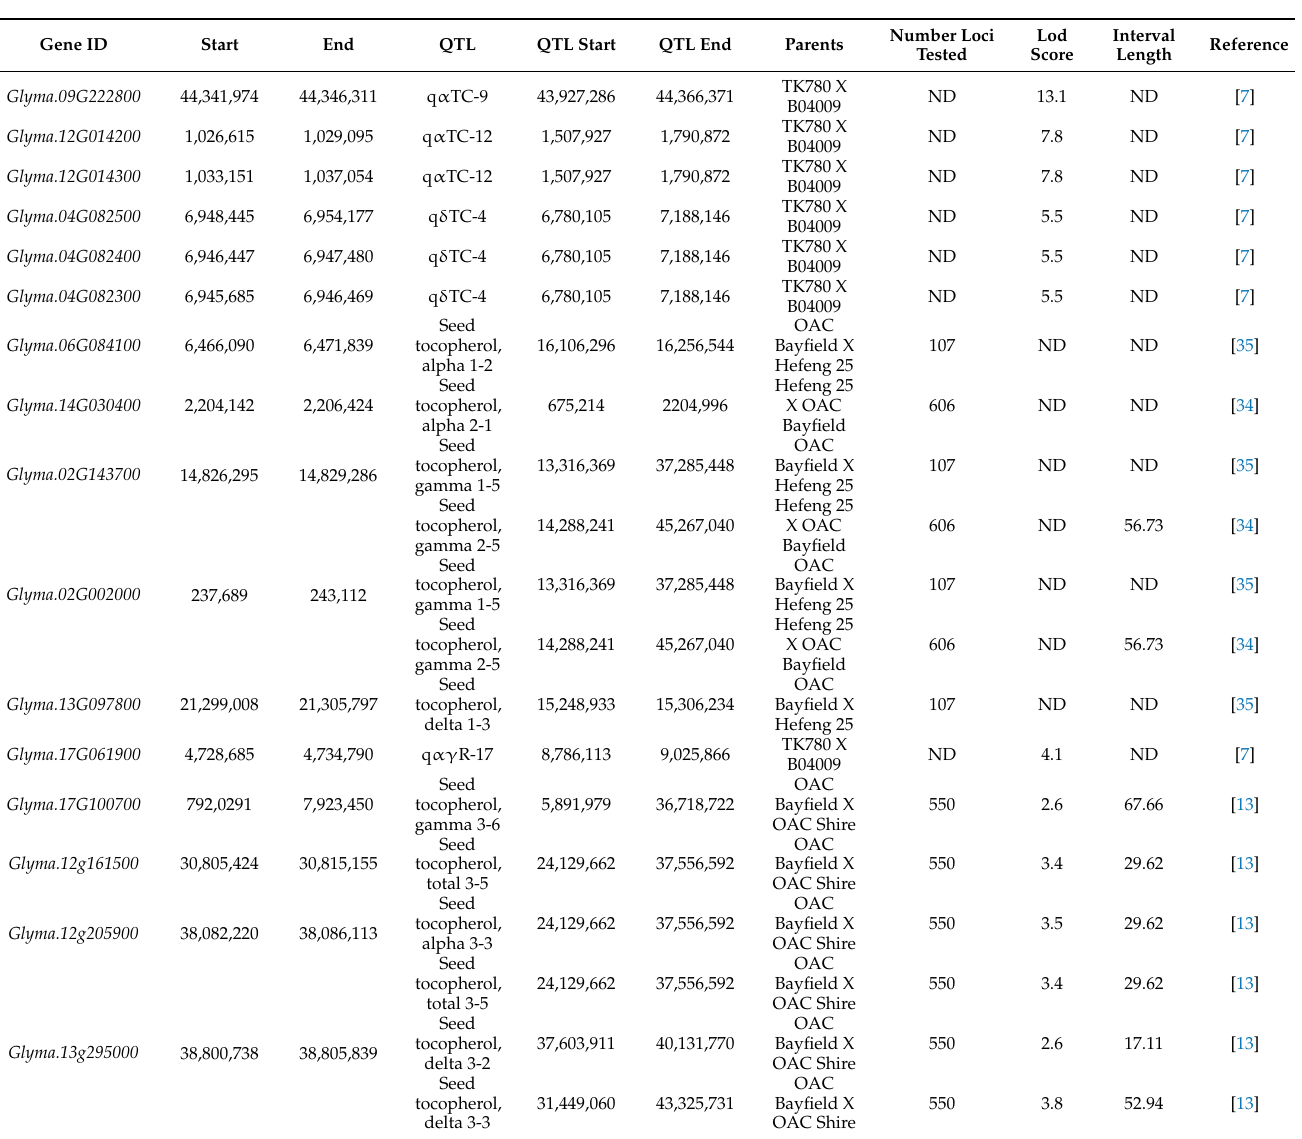
Table 5. Tocopherol candidate genes associated to the previously reported